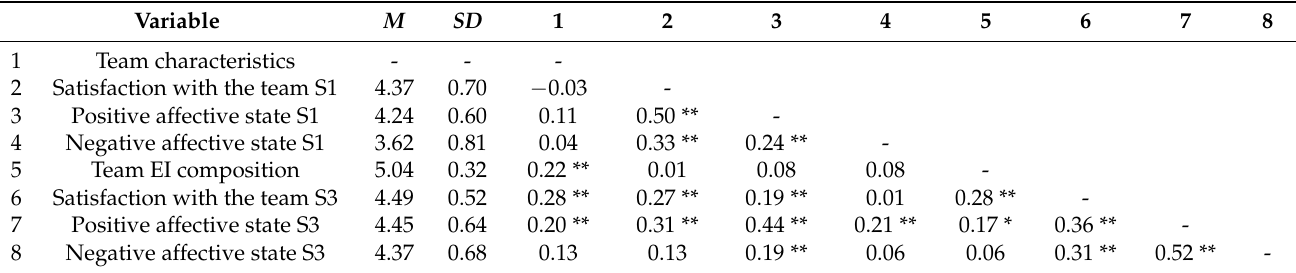
Table 2. Descriptive statistics and correlations for the study variables in experimental condition: Teams with